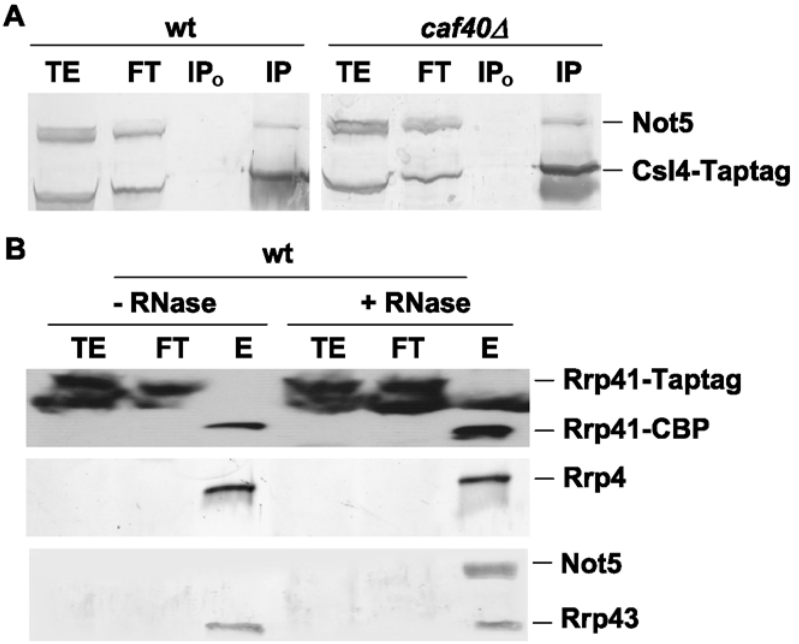
Figure 5. Not5 co-precipitates with Csl4 and Rrp41. A. Total protein extracts were prepared from wild-type or caf40 D cells expressing Tap- tagged Csl4. 2 mg of total protein was incubated with (IP) or without (IP 0 ) antibodies against CBP. 50 m g of total extract (TE), equivalent volume of unbound extract (FT) and the immunoprecipitate were loaded on SDS-PAGE followed by western blotting with antibodies against Not5, which revealed both Not5 and Tap-tagged Csl4 as indicated. B . 2 g of total protein extract from wild-type cells expressing Tap-tagged Rrp41 treated or not with RNAse as indicated were processed for tandem affinity purification of Rrp41. Equivalent amounts of total extract (TE), flow through (FT) or one fourth of the eluate precipitated by TCA, were loaded on SDS-PAGE and analyzed with antibodies against CBP to follow Rrp41, or against Rrp4, Rrp43 and Not5 as indicated.